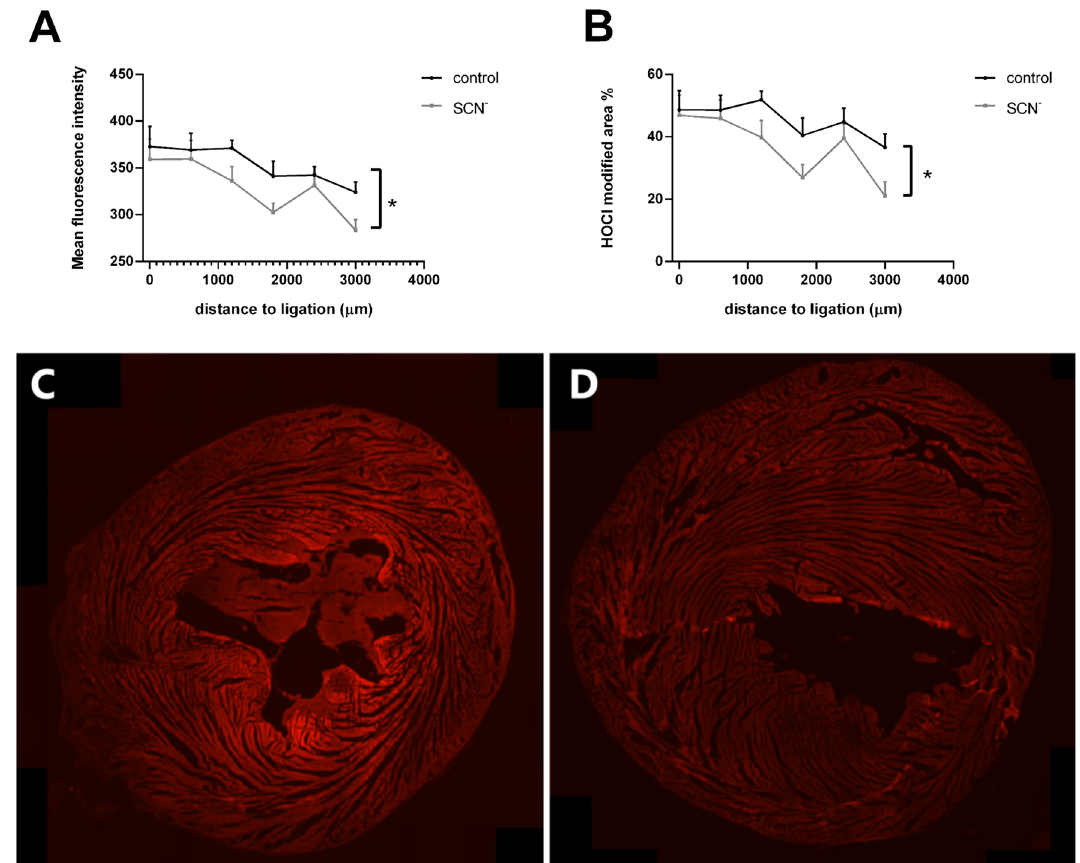
Figure 6. Effect of SCN − supplementation on the extent of formation of HOCl-modified proteins. The graphs show the differences in: ( A ) mean fluorescence intensity from 2D10G9 antibody epitopes, and ( B ) the percentage of fluorescence with an intensity over 350 compared to the background fluorescence (over 150) of the individual section, as a representation of the extent of 2D10G9 epitope recognition for HOCl-modified proteins, as measured on sections taken from the ligation site to the apex for control (black line) and SCN − (grey line) groups. Data represent mean ± SEM of n ≥ 6 rats with * showing a significant difference between vehicle/ IR and SCN – supplemented/IR groups using 2-way ANOVA with a Sidak post-hoc test. Panels C and D show representative fluorescent images of the 2D10G9 epitopes taken 1800 µm from the site of ligation from: (C) a vehicle/IR rat, and (D) a SCN – supplemented/IR rat, with the images recorded and displayed with the same instrument